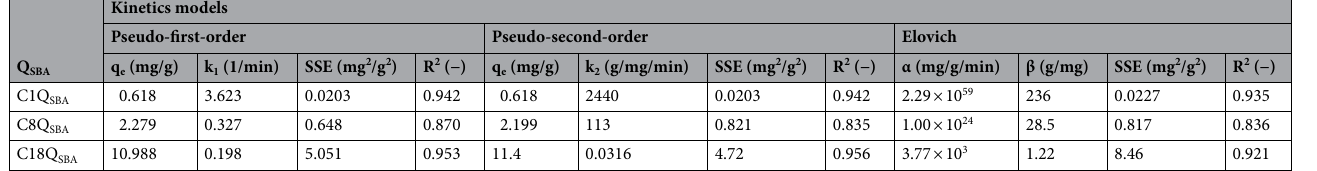
Table 2. Kinetics model parameters for adsorption of CBZ by Q SBA .